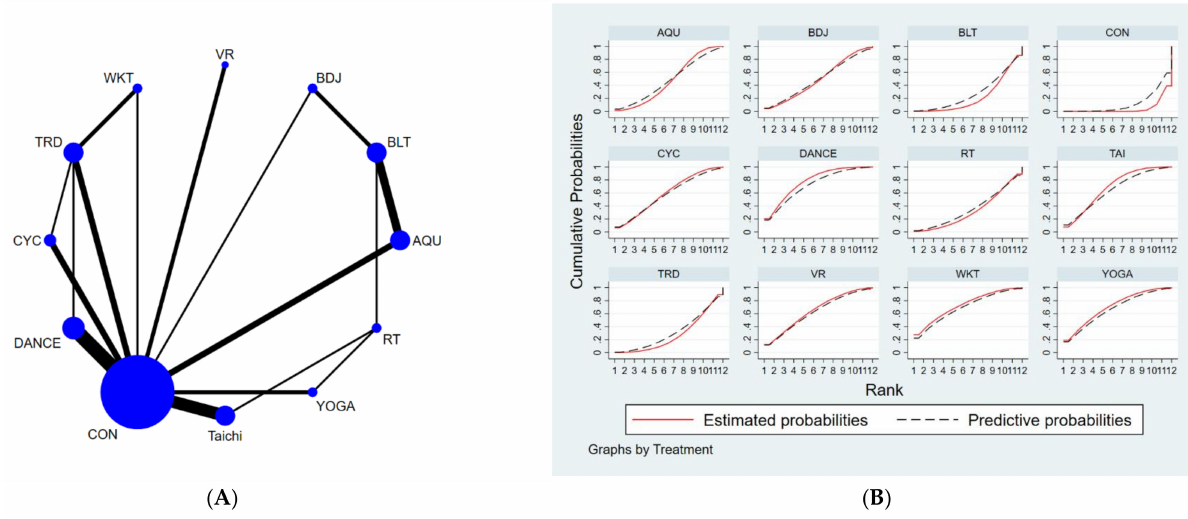
Figure 2. ( A ). NMA figure for UPDRS. ( B ). SUCRA plot for UPDRS.